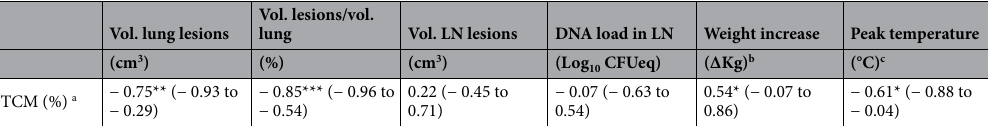
Table 3. Correlation between vaccine-induced immunity and vaccination outcome. Values show Spearman rank coefficient ± 95% CI. Vol. volume, LN lymph nodes, CFUeq colony forming units equivalents. * P <